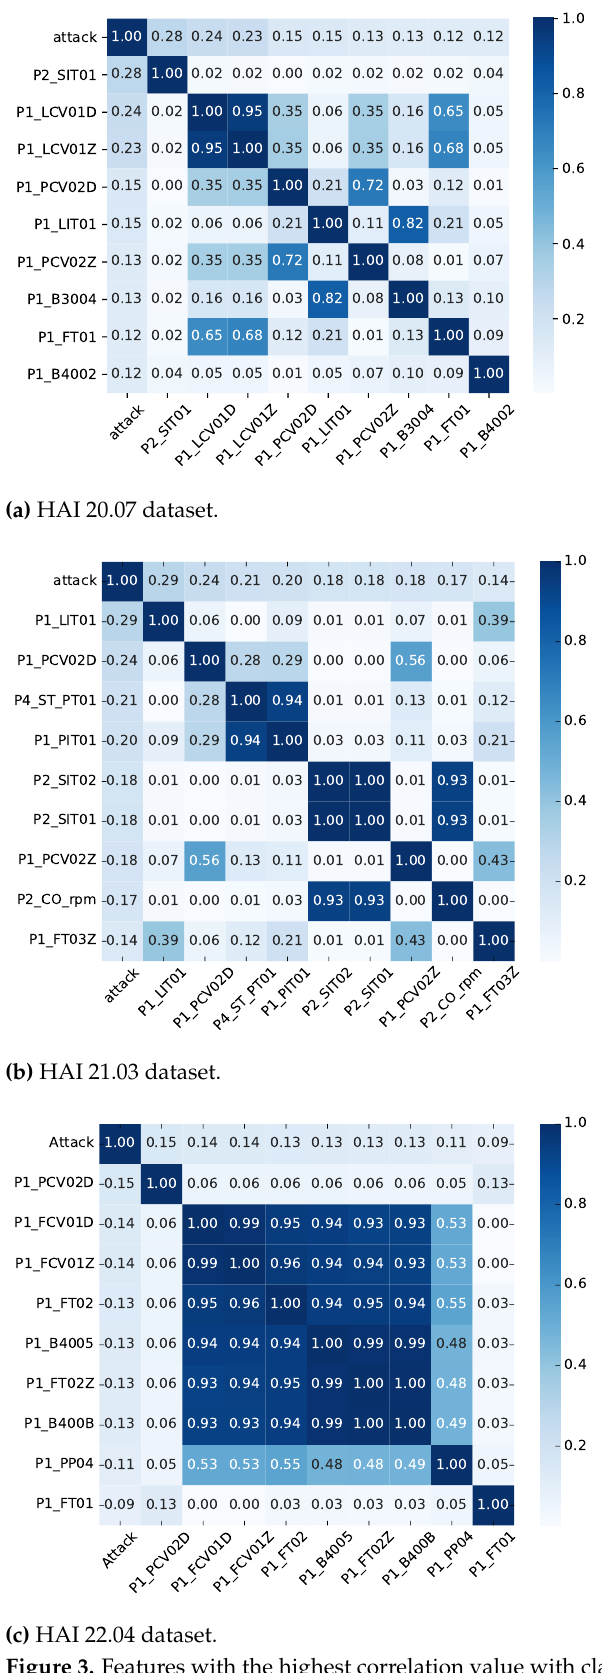
Figure 3. Features with the highest correlation value with class